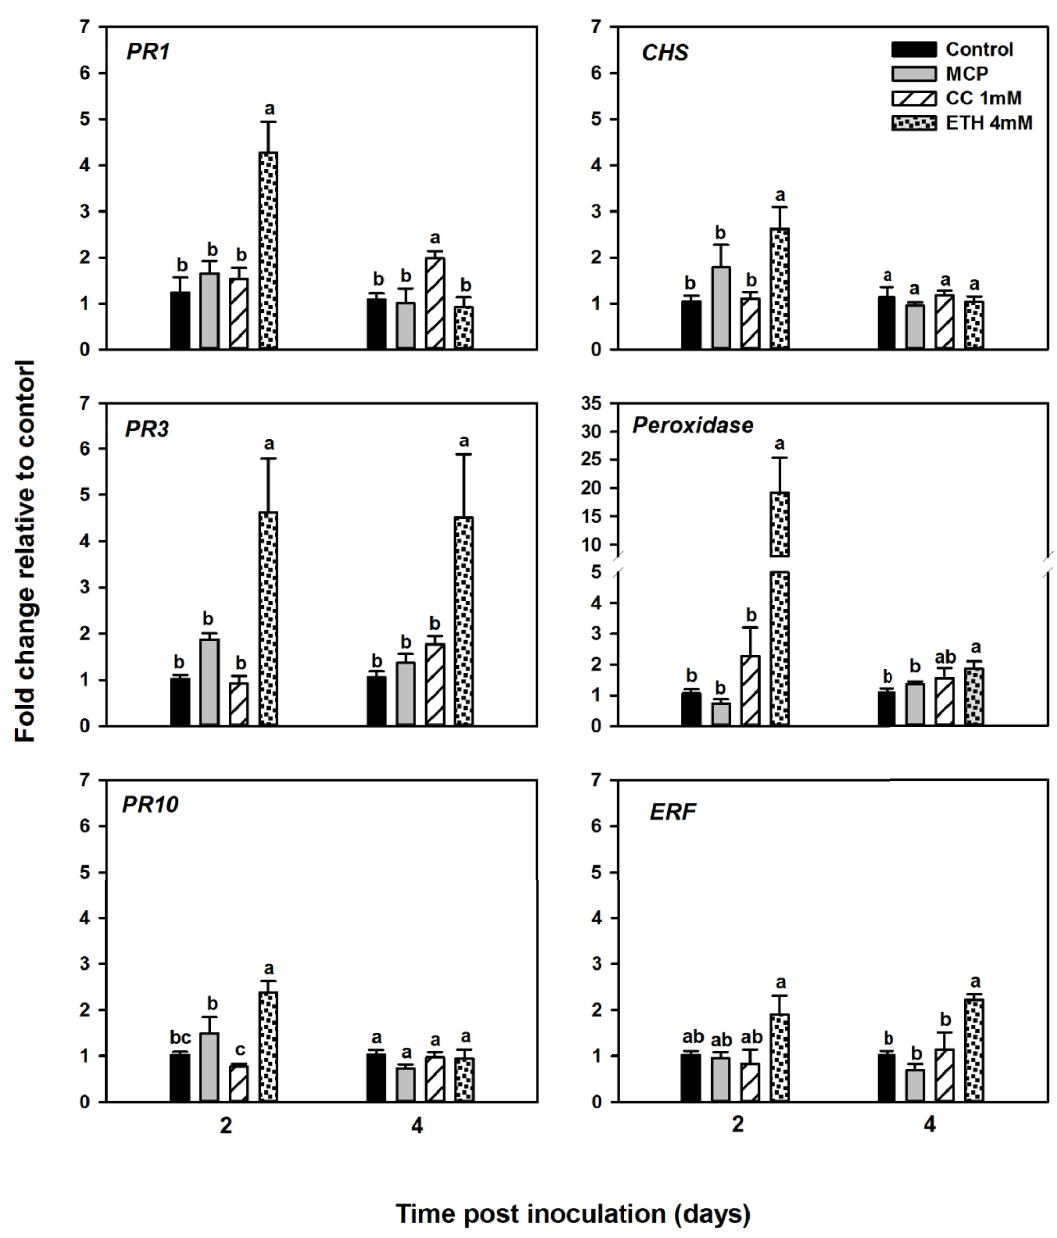
Fig 7. Effect of chemical treatments on the expression of soybean defense-related genes in the susceptible cultivar Williams 82 infected with Fusarium virguliforme . Soybean seedlings were drenched with water (control), ethephon 4 mM, cobalt chloride 1 mM, or foliar sprayed with 1-MCP twenty-four hours pre and post Fusarium virguliforme inoculation. Roots were sampled at 2 and 4 days after F . virguliforme (DAI). The level of expression of pathogenesis-related protein 1 ( PR1 ), Chitinase class I ( PR3 ), Intercellular pathogenesis-related protein 10 ( PR10 ), Chalcone synthase ( CHS ), basic peroxidase ( Peroxidase ), and ethylene response factor 1 ( ERF1 ), is shown relative to that of control plants. Each column represents the mean fold change of eight biological samples (four samples × two runs), and each sample consisted of a pool of two plants. Error bar indicates standard error of the mean (n = 8). Columns with different letters are significantly different ( P < 0.05).